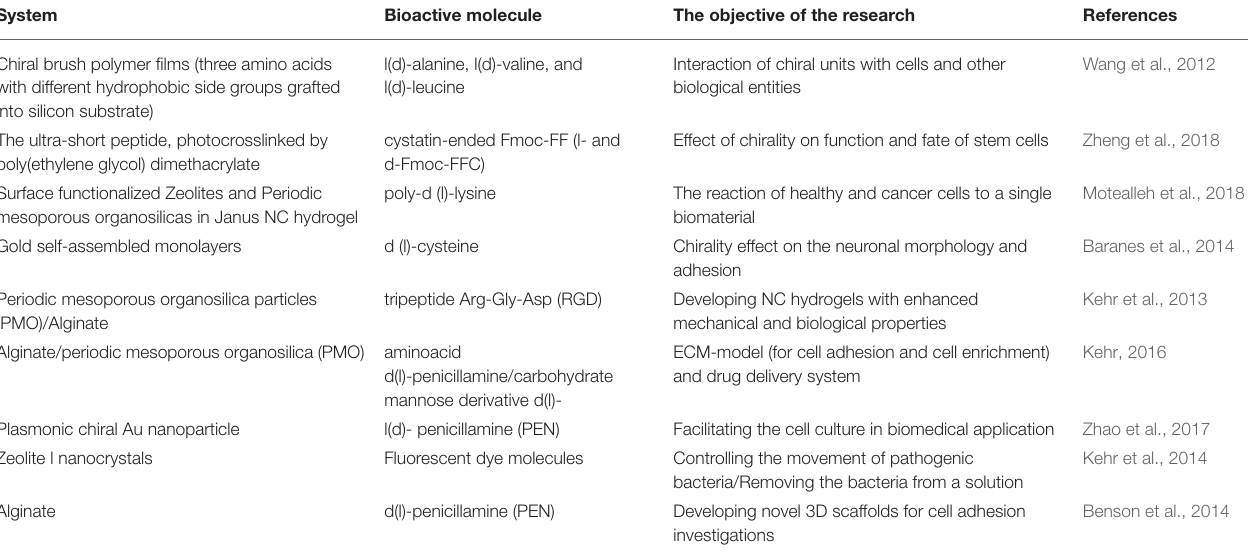
TABLE 1 | List of works dealing with chirality functionalized